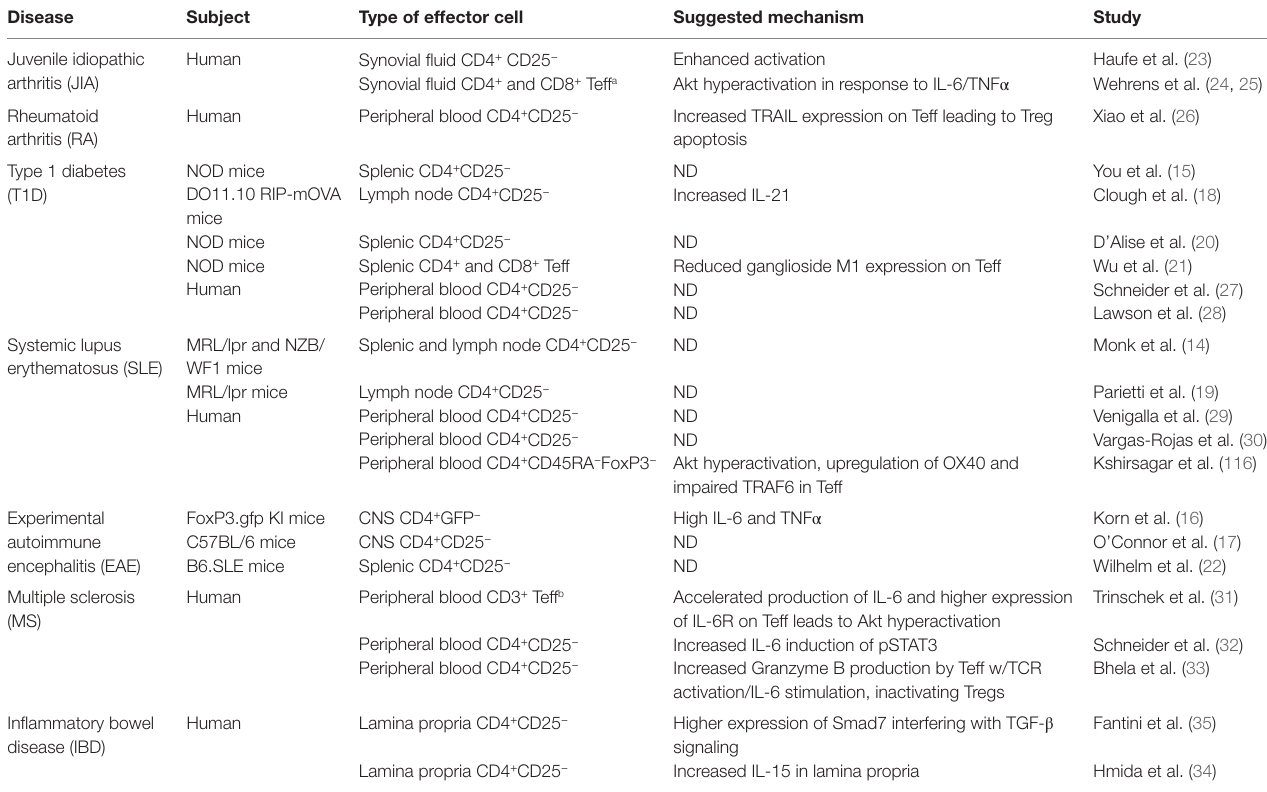
TABLe 1 | Diseases in which Tcon cells resist Treg-mediated suppression.